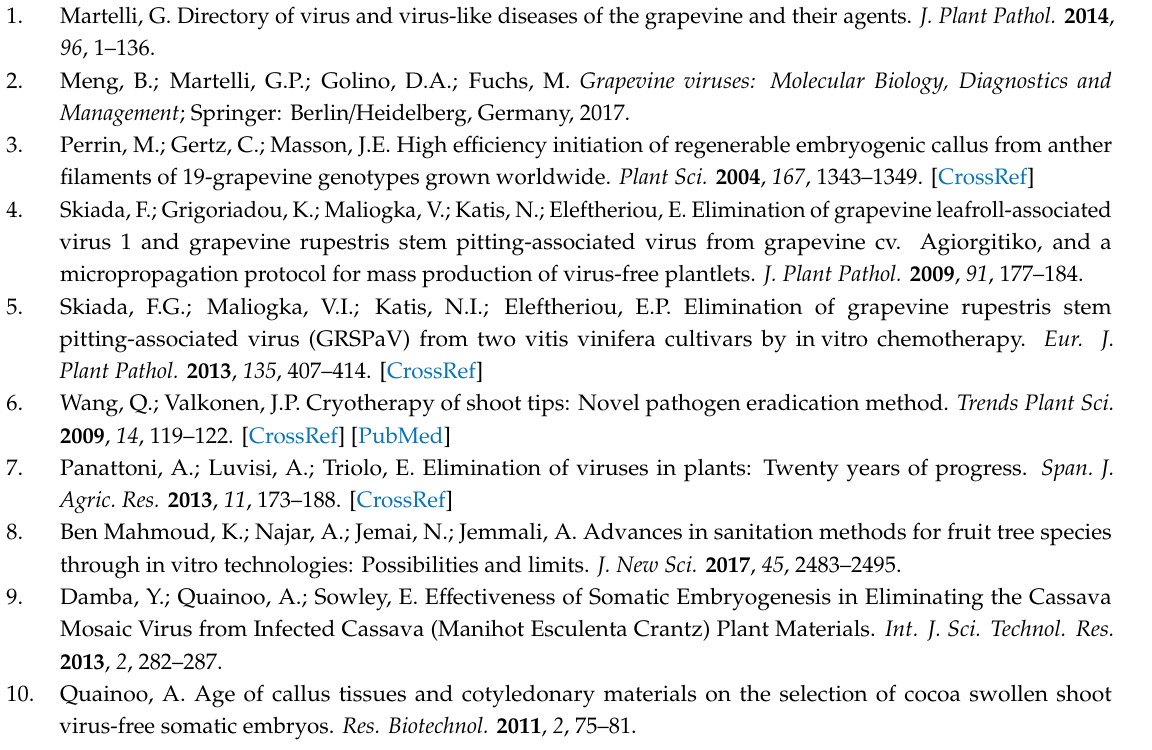
generated with somatic embryogenesis from Muscat Ottonel clone 7 by RT-PCR., Figure S3: Virus diagnostics of the eight independent lines generated with somatic embryogenesis from Muscat Ottonel clone 14 by RT-PCR., Figure S4: Virus diagnostics of the twelve independent lines generated with somatic embryogenesis (SE) or meristem culture (ME) from ‘Trilla’ by RT-PCR., Figure S5: Virus diagnostics of the eleven independent lines generated with somatic embryogenesis (SE) or meristem culture (ME) from ‘Sziren’ by RT-PCR and Supplementary Tables for Turcsan et al: Table S1: Review of published somatic embryogenesis based virus elimination protocols and their e ffi ciency on grapevine., Table S2: Basic information of the samples used for small RNA sequencing library preparation., Table S3: Initial statistics of the sequenced small RNA libraries., Table S4: Detailed results of the bioinformatics analysis of small RNA HTS of di ff erent libraries., Table S5: Sequences of the PCR primers used for virus detection with their appropriate